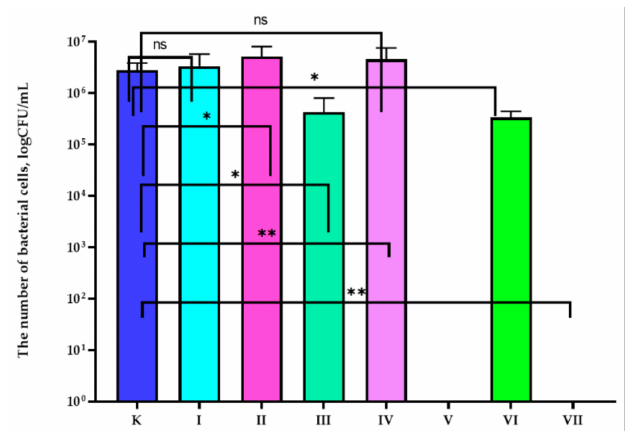
Figure 3. The influence of coated, active films on P . syringae growth. One-way ANOVA test: p < 0.001; **— p < 0.01; *— p < 0.05; ns—not